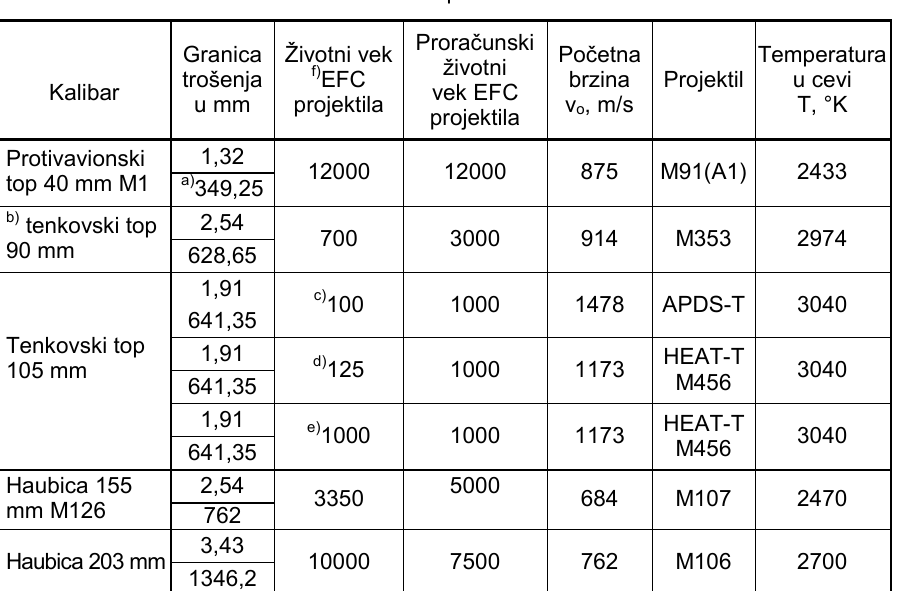
Granice zabrane upotrebe cevi oru đ